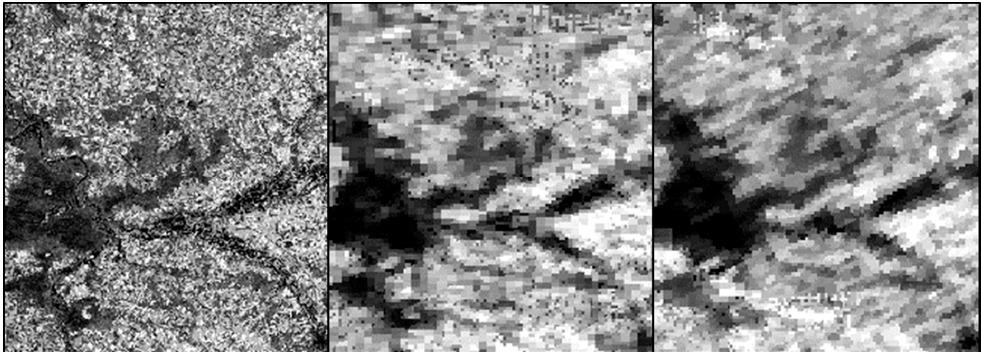
Figure 8. Surface reflectance products for Band 5 (near-IR, 850 to 880 nm) of Landsat 8 ( left image) and Band 2 (near-IR, 841 to 876 nm) of Terra ( center ) and Aqua ( right ) MODIS acquired on Day 110 (20 April 2015). Image map coordinates and processing options are identical to images displayed in